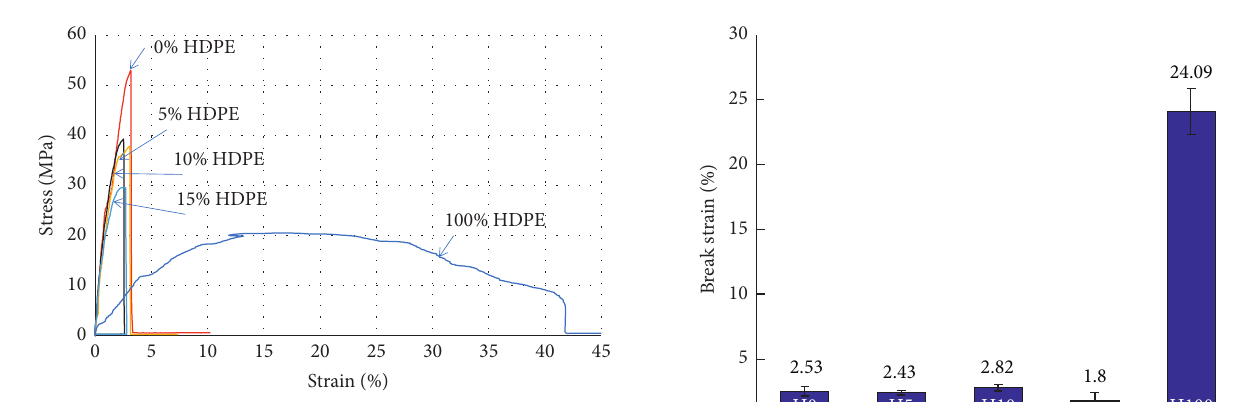
Figure 8: Stress-strain curves of samples.